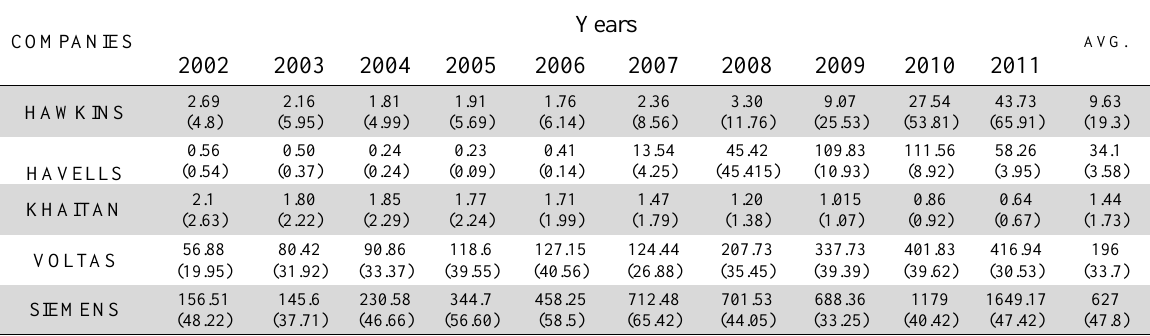
Analysis of Average Cash Holding (Avg. cash holding as percentage of total assets) of Selected Companies of Consumer Durable sector Rs. in crore (also in % of total assets)